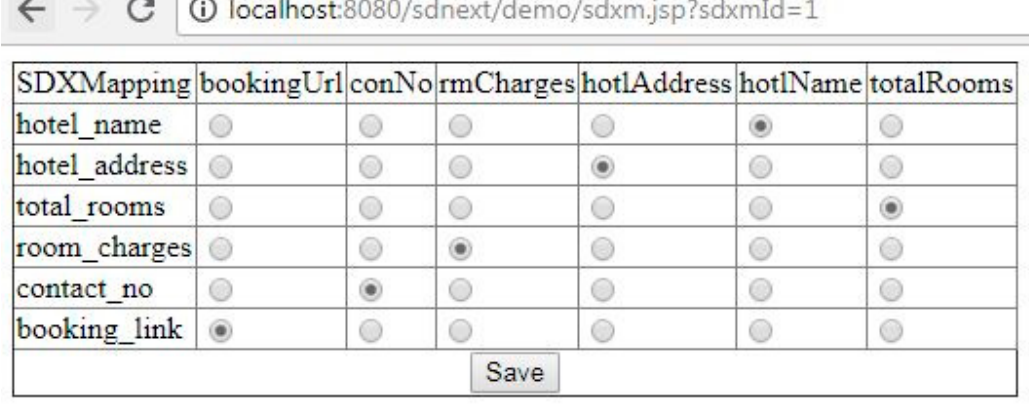
Figure 9. SDXMapping between EU#01 and MSP#01.